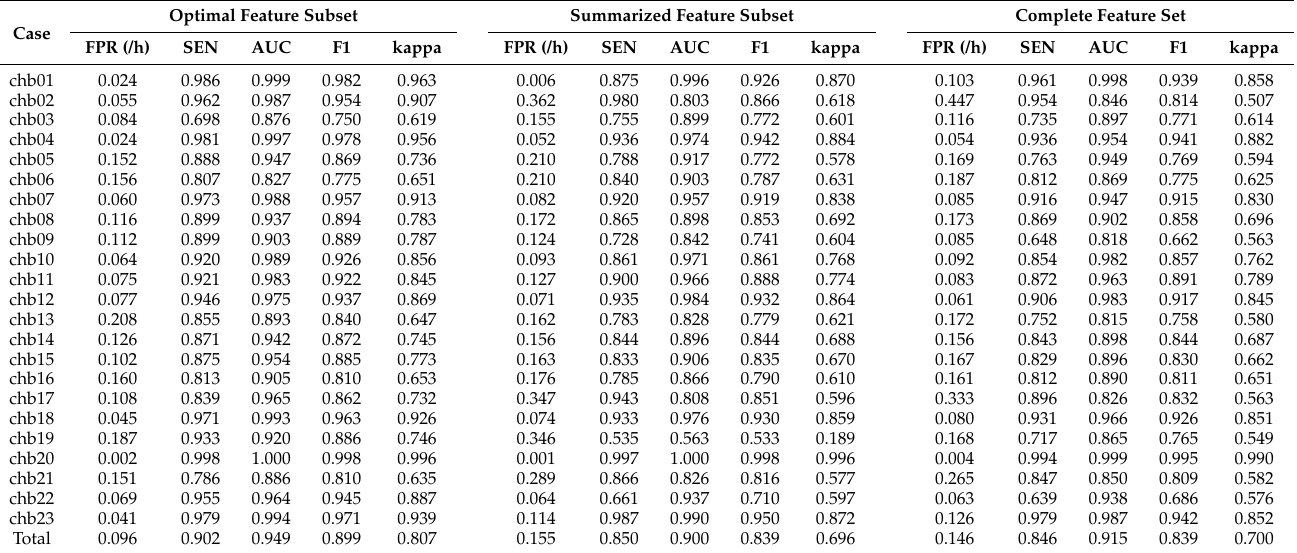
Figure 6. Comparison between the classification accuracy obtained using optimal, summarized, and complete feature sets. Table 4. Performance of models when using optimal, summarized, and complete feature